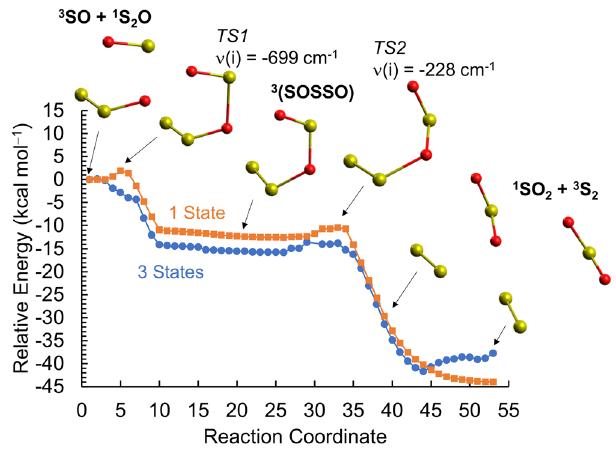
Fig. 2 | 3 SO+ 1 S 2 O → 1 SO 2 + 3 S 2 reaction energy pro fi le. Two approaches of multi- con fi gurational quantum chemistry (CASPT2) are shown, with a wavefunction basedonlyon the lowest-lying electronic state (1State)orawavefunction allowing the interaction between the 3 lowest-lying nearby states (3 States). Benchmark analysesdemonstratethelattertobeofhigheraccuracy,whiletheformerisusedas sensitivity test (see section 4.1 in the SI). A two-step process is found via an inter- mediate adduct 3 (SOSSO)involving energy barriers heightsof atmost ~2kcalmol − 1 for both approaches to access the transition states for the adduct formation ( TS1 ) and S – O bond cleavage from the adduct ( TS2 ). The values of the imaginary fre- quency that characterize the TSs are also shown. Red and yellow balls represent oxygen and sulfur atoms, 3 O 12 , the pseudo- 2 at the relevant altitude of ~64 km from Zhang et al. fi rst order rate ( k ) appears lower for 3 S recombination (Eq. 6) than that for oxidation (Eq. 7).